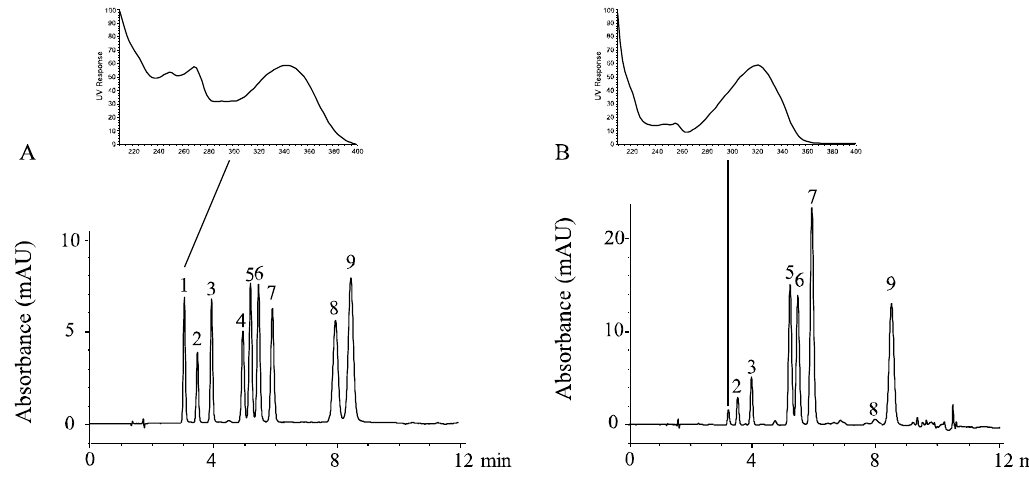
Figure 2. HPLC chromatograms of long-leaf orange peel oil (OPO) showing polymethoxyflavones (PMFs). Notes: ( A ) The mixed standard chromatogram with the UV spectrum of Compound 1;